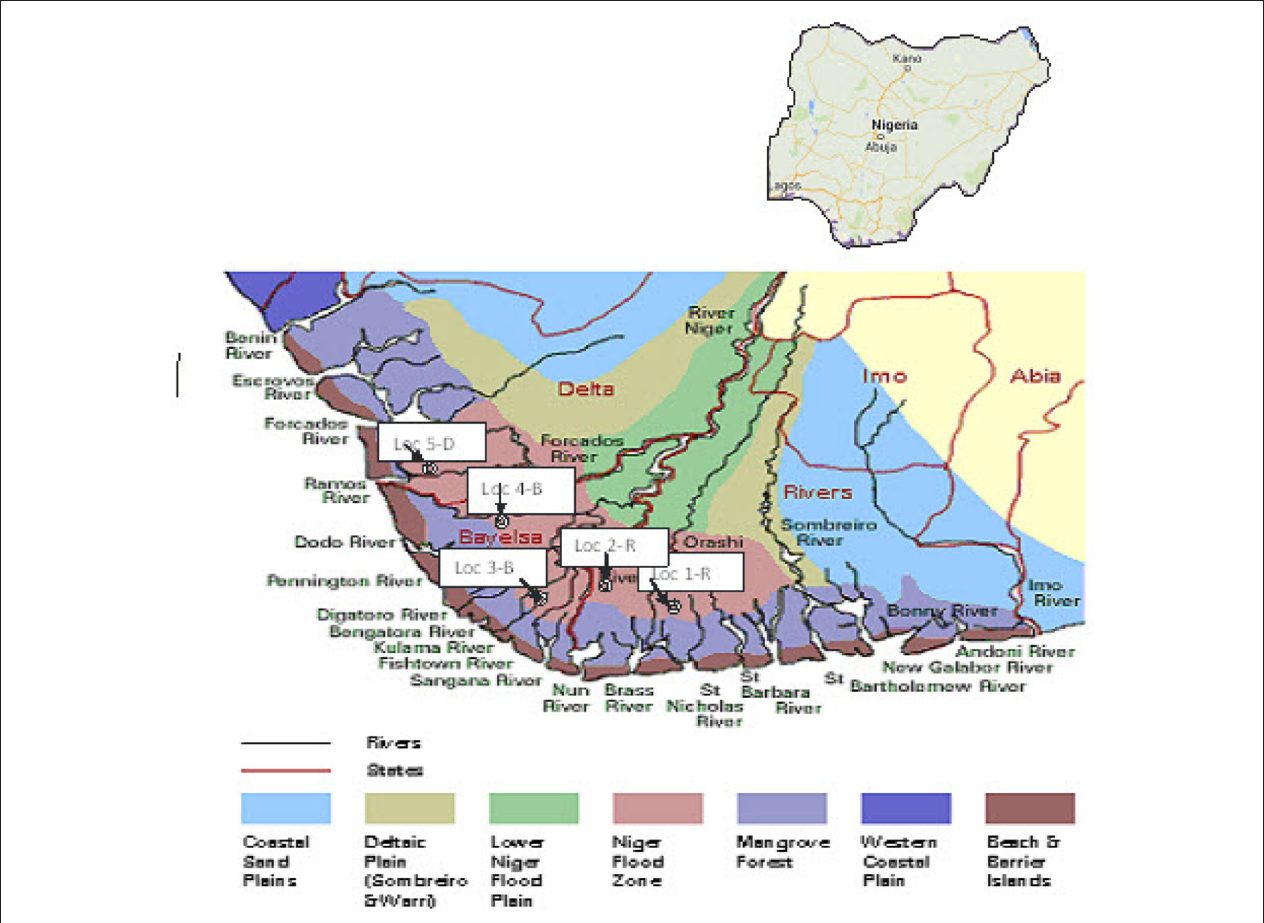
FIGURE 1 | Active soil zone and layout of sampling i. The zone as delineated by Akpokodje and Arumala (1987) is characterized superficially by n study